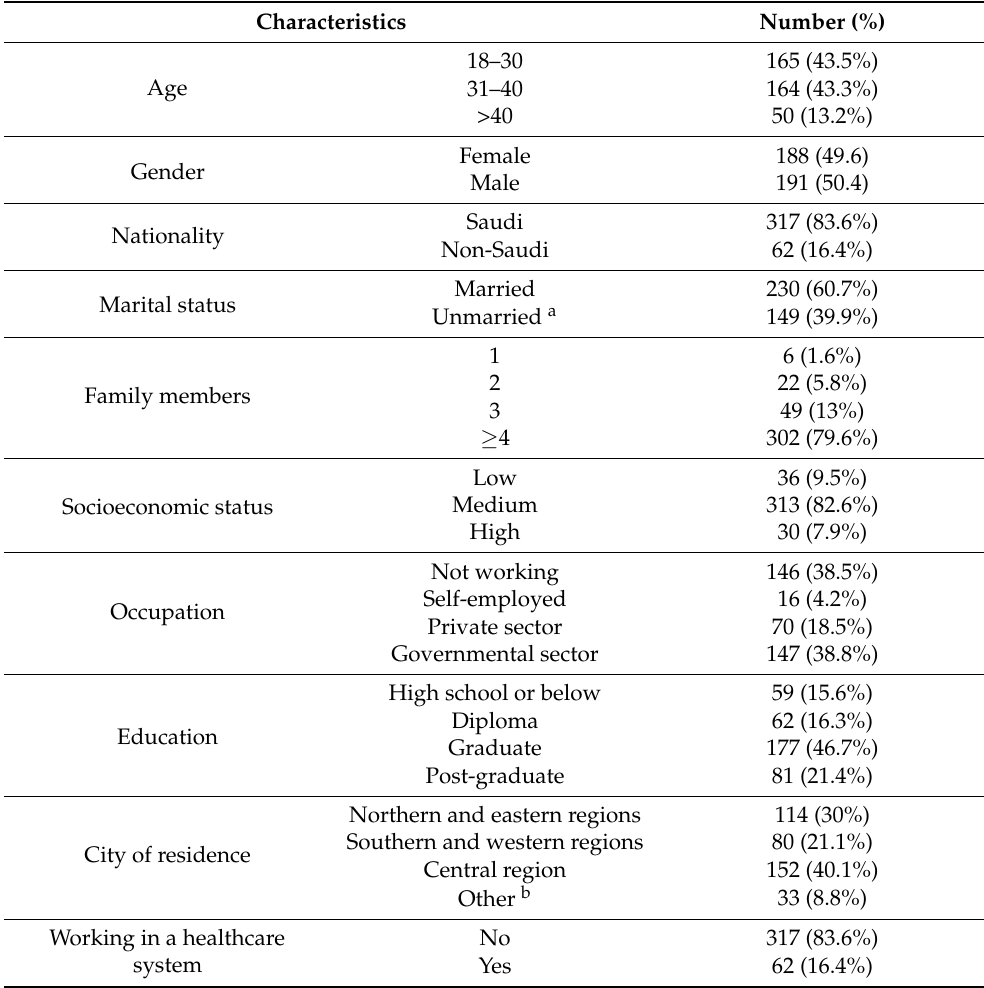
Table 1. Sociodemographic characteristics of the parents assessed for their willingness to vaccinate their children with a COVID-19